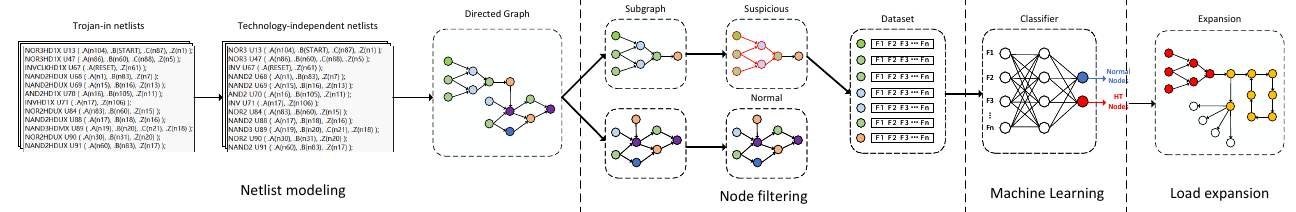
Figure 2. An overview of the Trojan-detection framework. The input netlists are converted to technology-independent netlists, and then modeled as directed graphs. Subgraphs divided from the directed graphs are matched with templates to access their dangers, and the features of nodes in suspicious subgraphs are used as datasets. The nodes are classified as HT or normal nodes by ML- based HT detection based on their features. Finally, the HT nodes are expanded to obtain unknown HT payload and a complete HT